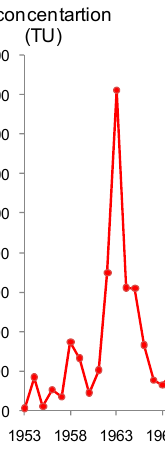
Figure 9. Relationship between groundwater conductivity (EC) and tritium concentration.